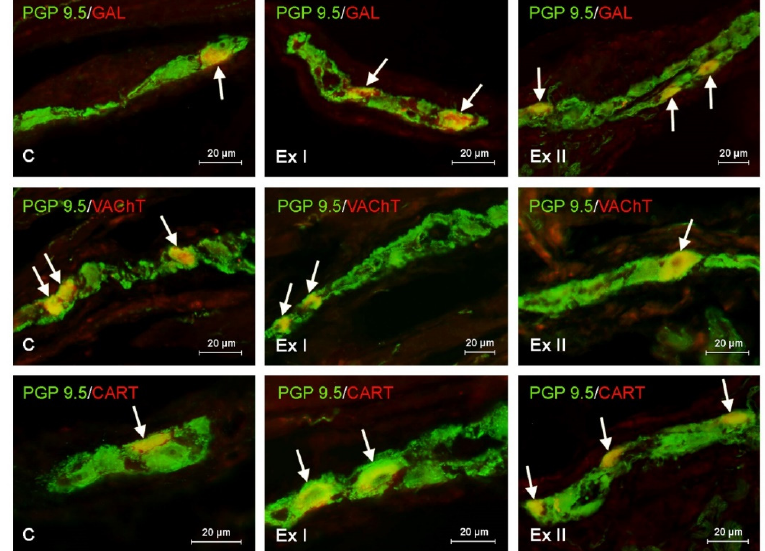
Figure 2. Distribution of neurons immunopositive to panneuronal marker- protein gene-product 9.5